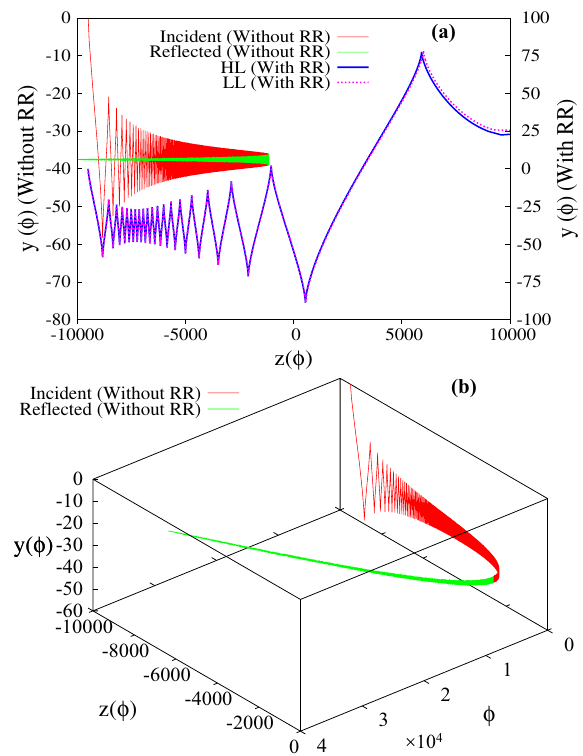
Figure 4. ( a ), ( b ) Represent the trajectory of the particle in the absence/presence of radiation reaction effects. The chosen initial conditions and the laser parameters are same as in Fig. 3. The red and green curves respectively represent the forward and reflected motion of the particle in the absence of radiation reaction (values correspond to y-axis on the left). The blue and magenta curve in ( a ) respectively represent the trajectory of the particle in the presence of radiation reaction effects (values correspond to y-axis on the right) as obtained by solving the Hartemann-Luhmann and the Landau-Lifshitz equation of motion. Note that the apparent discrepancy in the initial conditions seen in ( a ) for without and with radiation reaction is due to the use of different axes i.e. left y-axis is for without radiation reaction and right y-axis is for with radiation reaction